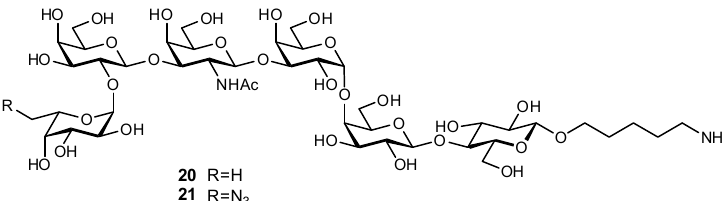
Figure 8. The chemoenzymatic synthesis of a 6-azido-Fuc Globo H derivative ( 21 ) afforded a glycomimetic which when incorporated into a conjugate vaccine elicited a strong IgG immune response in mice. The elicited antibodies were cross-reactive with the native Globo H antigen and mediated complement-dependent cell cytotoxicity against MCF-7 tumor cells [145] .